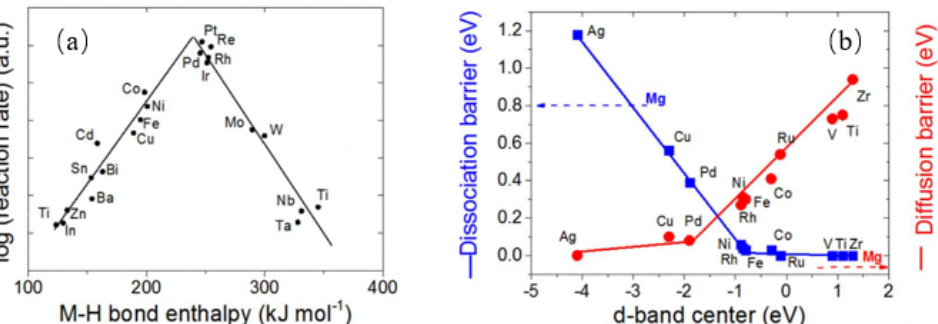
Figure 12. ( a ) Volcano plot for the hydrogen evolution reaction as function of the metal hydrogen bond enthalpy. (Repro- duced with permission from ref. [144]. Copyright 1972 Elsevier). ( b ) Activation energy barrier for hydrogen dissociation (blue) and diffusion (red) of hydrogen on pure Mg and metal-doped Mg surfaces as a function of the d-band center positions. (Reproduced with permission from ref. [48]. Copyright 2009 Elsevier).